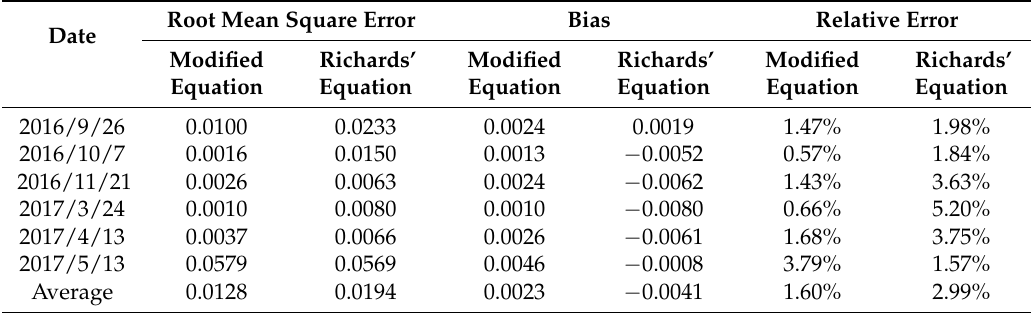
Table 4. Simulation accuracy of modified equation and Richards’ Equation for deeper soil layers (50